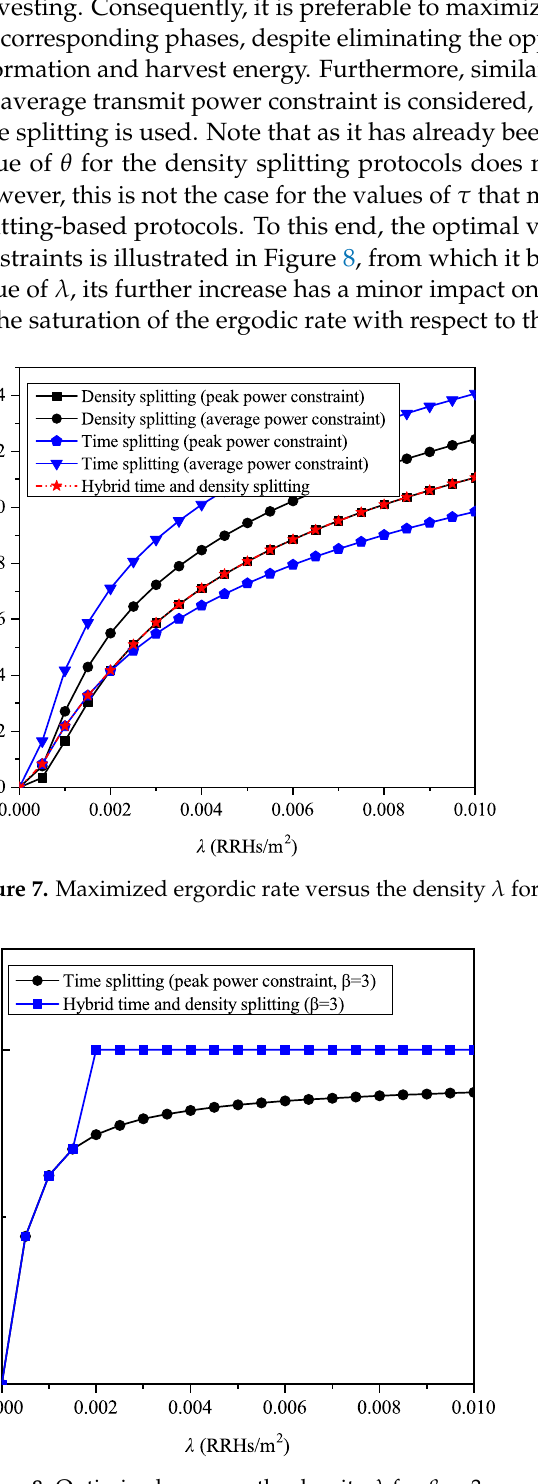
Figure 8. Optimized τ versus the density λ for β =